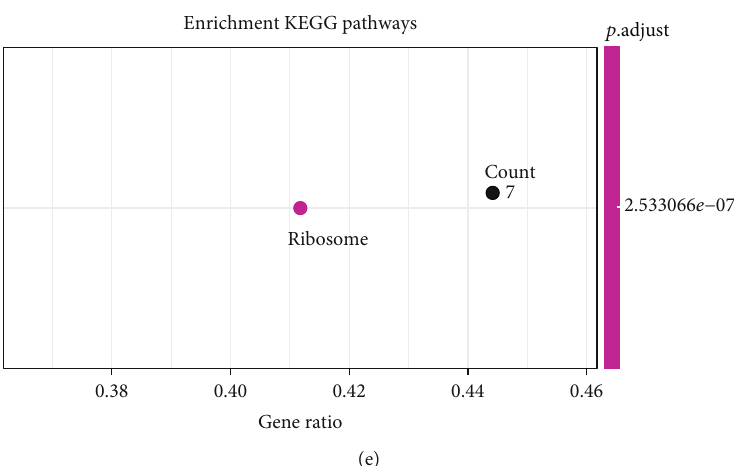
Figure 2: WGCNA of metastasis-related module. (a) The clustering dendrograms showed 54 coexpression modules recognized by WGCNA. (b) The correlations and p value of module-traits associations. (c) The cyan module genes were highly correlated with metastasis status. (d) Gene Ontology (GO) analyses of the 41 hub genes. (e) KEGG pathways analysis of the 41 hub